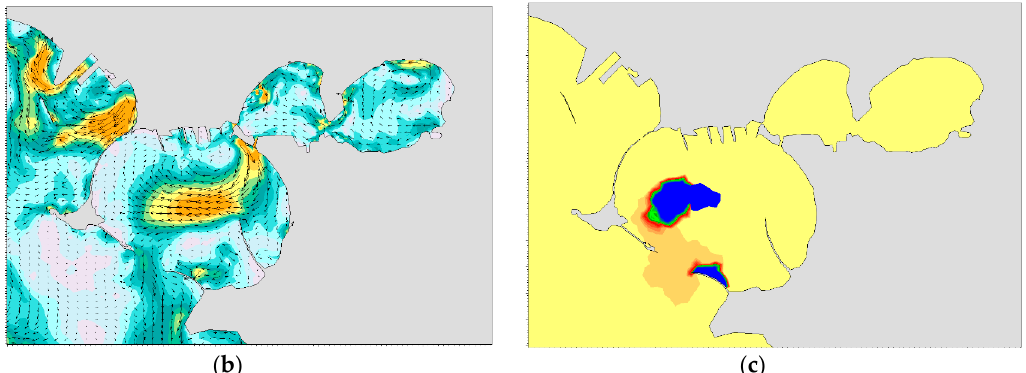
Figure 10. Cont. Figure 10. Cont.